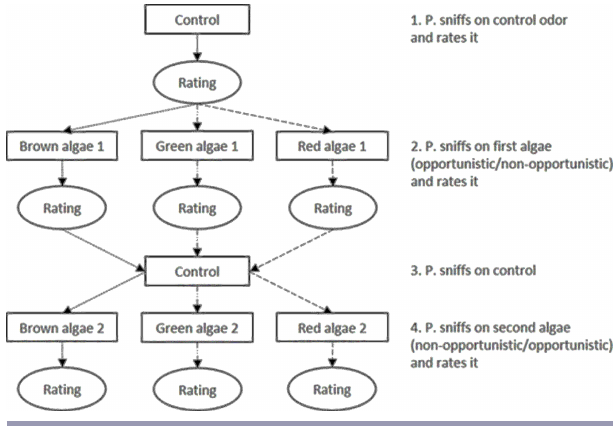
Fig. 1 . Test sequence of odor experiment. Participants (=